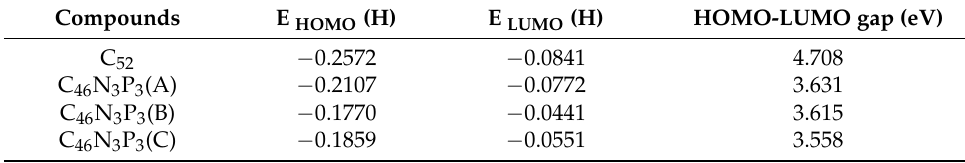
Table 11. Frontier molecular orbital energies and computed HOMO-LUMO gap (HF/LanL2DZ).